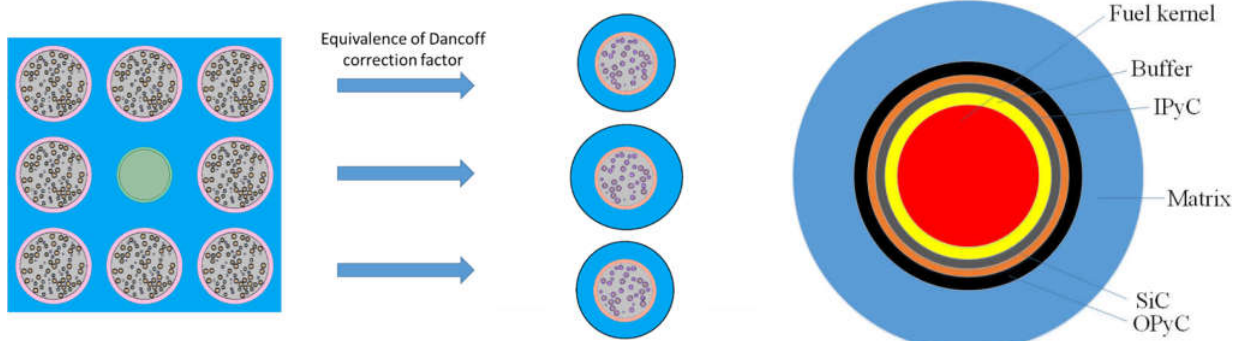
Figure 1 Equivalent 1-D pin cells of the FCM fuel lattice Figure 2 Volume-equivalent 1-D